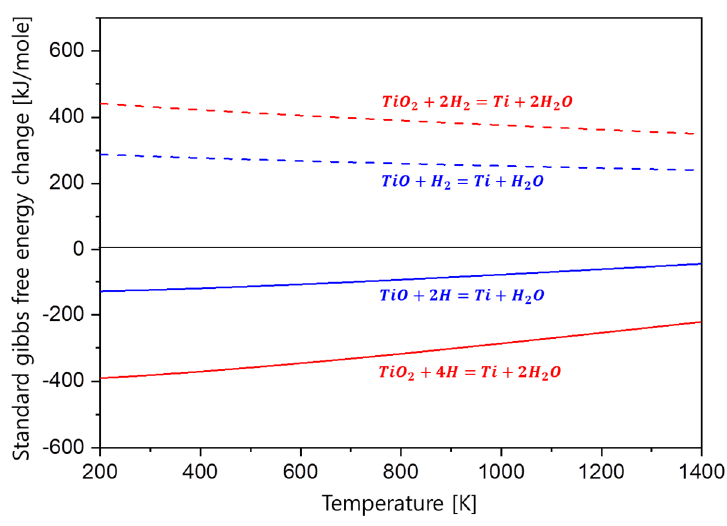
Figure 6. Standard Gibbs free energy changes in the reduction behavior of TiO and TiO 2 oxides with respect to hydrogen molecule and atomic hydrogen.